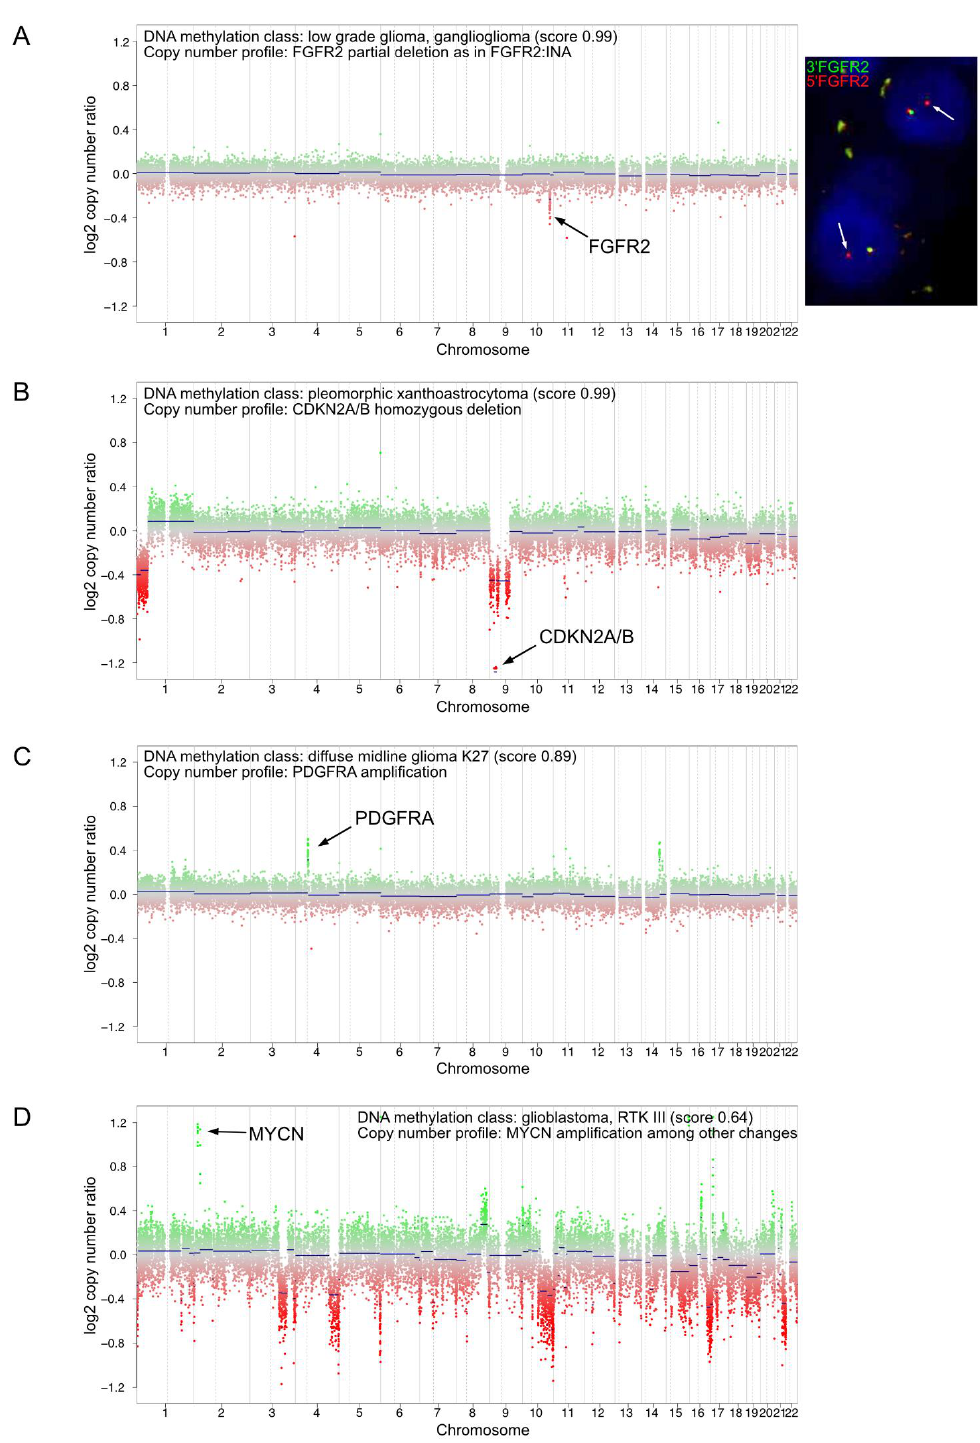
Figure 4. Examples of CNV plots from DNA methylation array showing relevant alterations for diagnosis, prognosis or precision medicine. ( A ) Example of a low-grade glioma (case #55) with a focal loss in chromosome 10q on the CNV plot (left plot) suggesting a FGFR2 rearrangement subsequently confirmed by interphase FISH using a break-apart probe flanking FGFR2 (right picture). The white arrows show the FGFR2 locus rearranged. Magnification x600. ( B ) Example of a pleomorphic xanthoastrocytoma (case #50) with a CNV plot showing a homozygous deletion of CDKN2A/B . ( C ) Example of a diffuse midline glioma H3K27 mutant (case #62) with a CNV plot showing PDGFRA amplification. ( D ) Example of a glioblastoma RTKIII (case #53) with a CNV plot showing MYCN amplification. CNV plots depict chromosomes 1 to 22 with the p-arm (left) and the q-arm (right) separated by a dotted